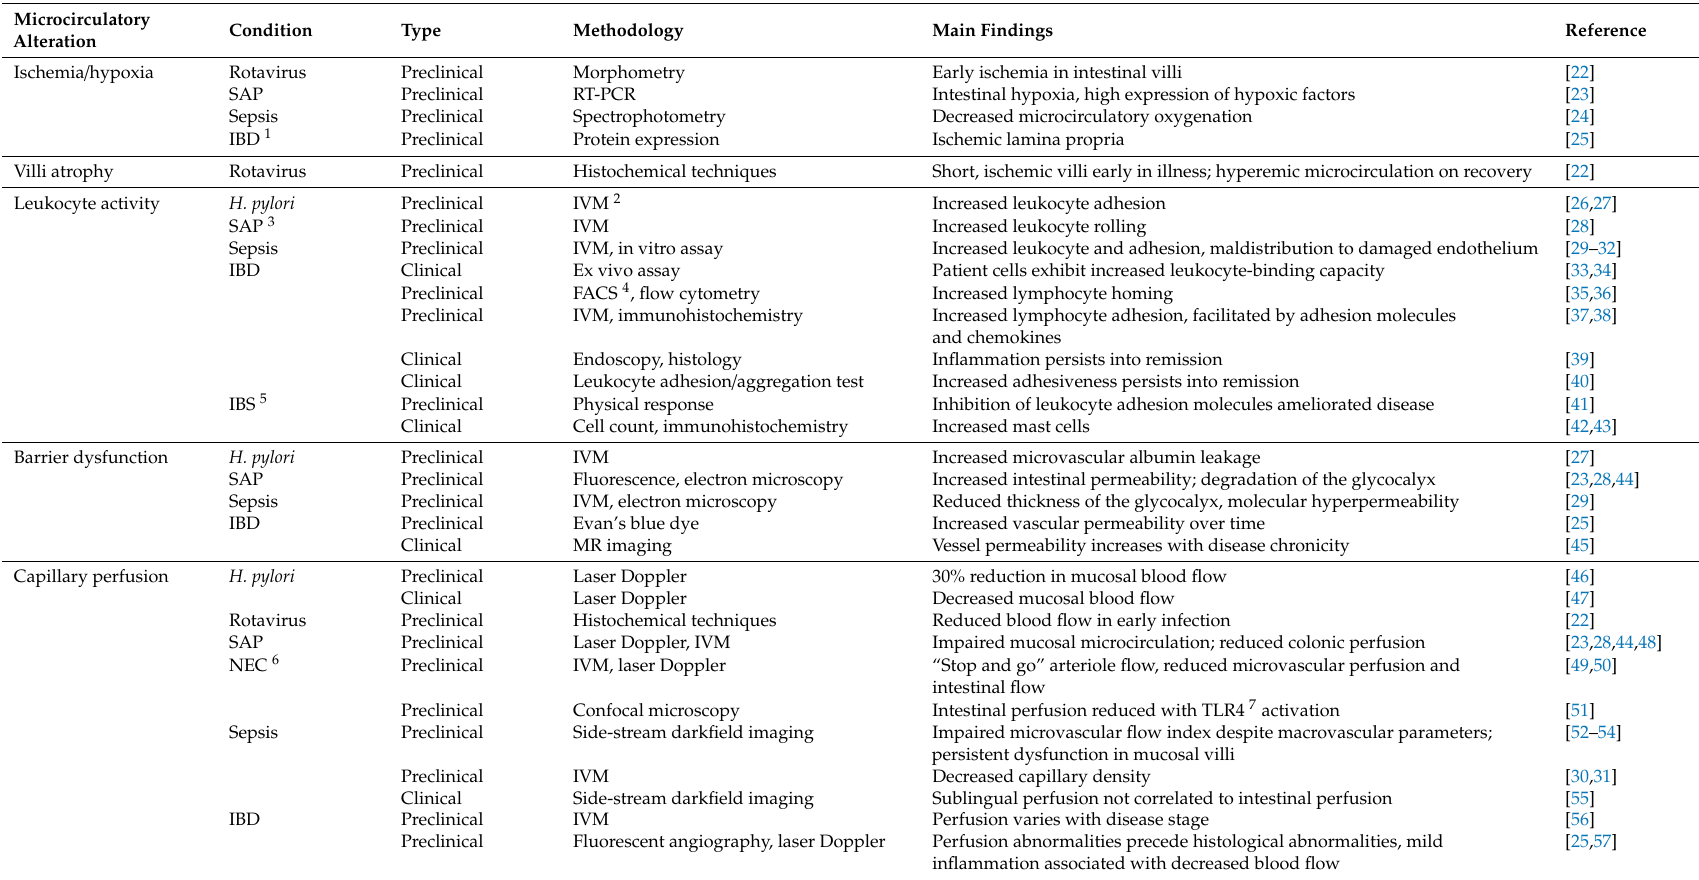
Table 1. Possible microcirculatory alterations of the intestine are listed, along with associated conditions, as discussed in this